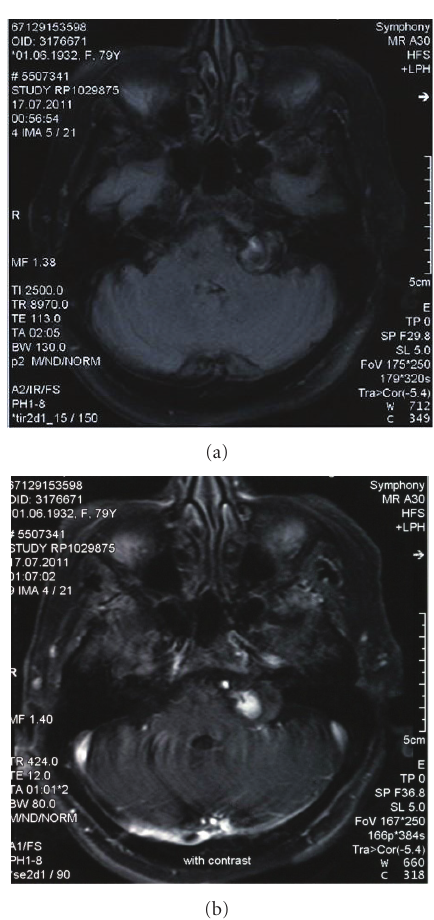
Figure 1: (a) and (b) Axial flair and axial postcontrat T1 sequences of cranial magnetic resonance imaging show a lesion with heterogeneous intensity with contrast enhancement.